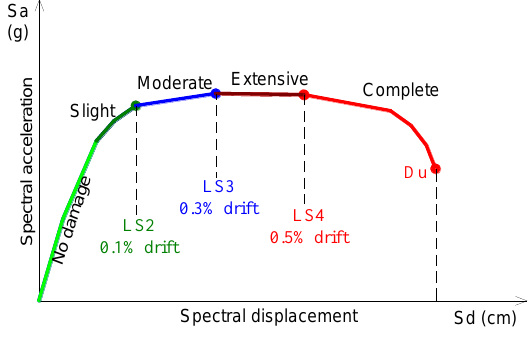
Figure 7.Performance levels on pushover curve Fig. 7. Performance levels on pushover